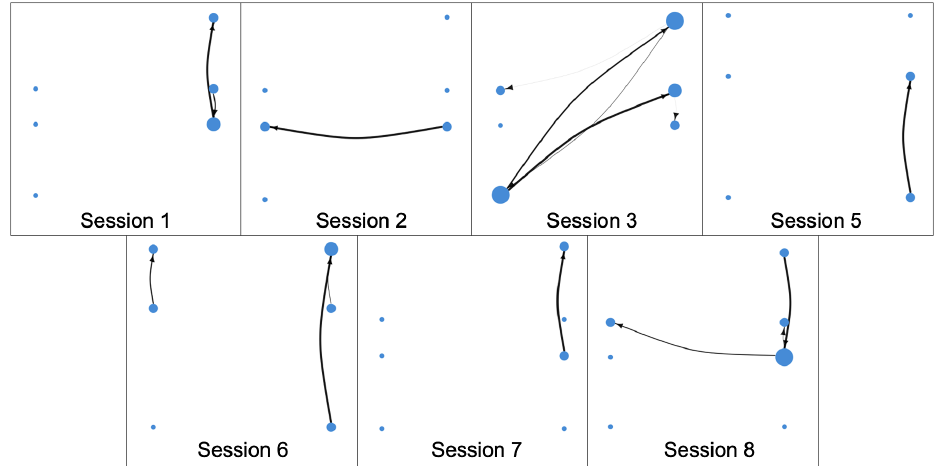
FIG. 11. Network diagrams for all coded sessions of section 1.